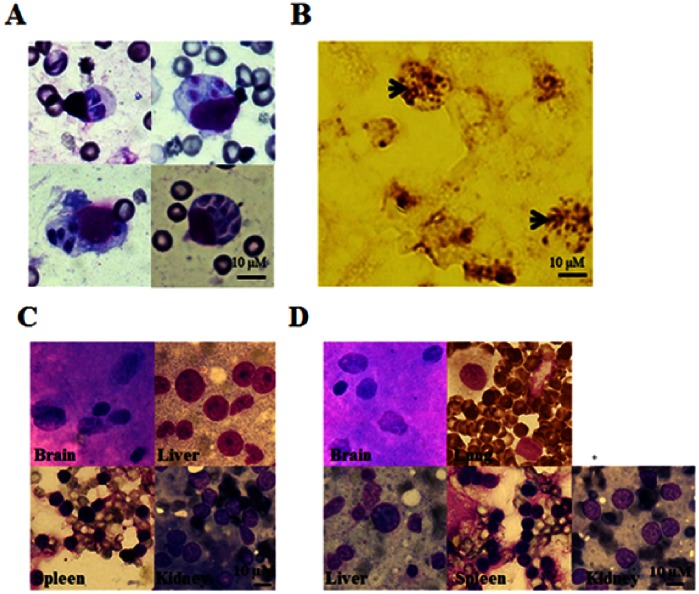
Analysis of T. gondii infection in rat alveolar macrophages in vivo.Rats were infected by pulmonary infection (n = 6); peritoneal infection (n = 6) and uninfected controls (n = 6; injected with PBS) to determine whether T. gondii could be taken up in vivo. (A) At 24 hrs after the time of infection, the lungs of infected rats were sectioned, directly smeared and then stained with Diff. The results are representative of the replicated experiments. (B) Similarly, the lungs of these infected rats were steeped in 10% polyphosphate formalin for 24–48 hrs, then treated by immunohistochemistry with an specific anti-toxoplasma antibody. The arrows indicate the proliferation of T. gondii in RAMs in vivo. The results were observed by microscopy (100×). The results are representative of the replicated experiments. (C) Diff stained section of brain, liver, spleen and kidney tissue following pulmonary infection showing that parasites could only be found in alveolar macrophages and not in other tissues. The results are representative of the replicated experiments (6 rats per experiment). (D) Diff stained section of brain, lung, liver, spleen and kidney tissue following peritoneal infection showing that parasites could not be found in any tissues. The results are representative of the replicated experiments (n = 6).